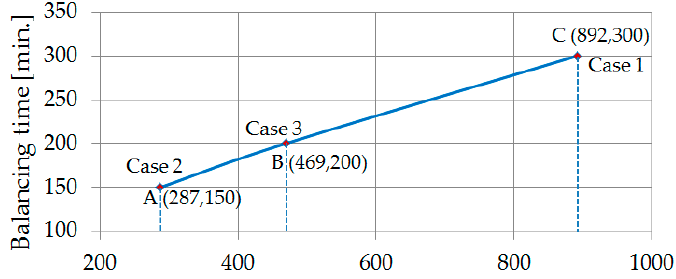
Figure 15. The balancing time vs the voltage difference between two modules.